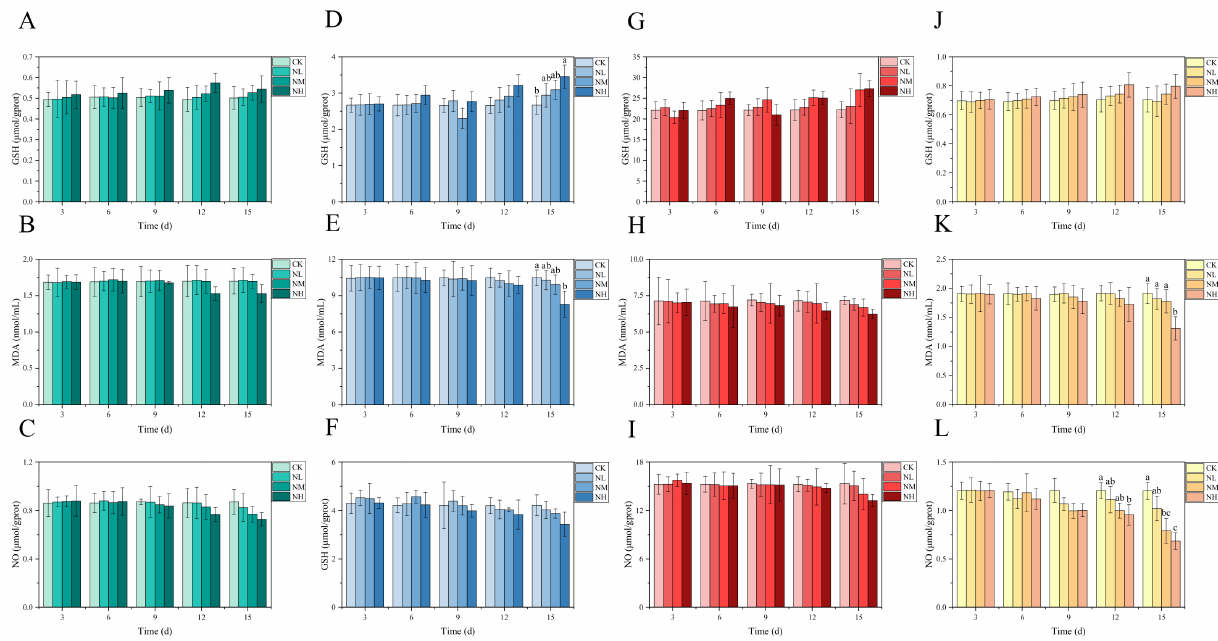
Figure 6. Effects of dietary supplementation of NCG on juvenile M. salmoides. ( A – C , D – F , G – I , and J – L ) represent the biochemical parameters (GSH, MDA, and NO) in the gill, brain, liver, and kidney. The bars represent the mean ± S.D. ( n = 3). Different letters indicate statistical differences ( p <